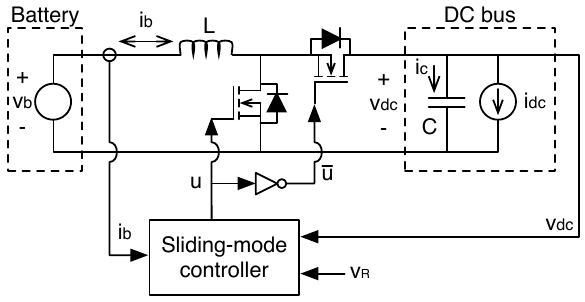
Figure 3. Structure of a unified sliding-mode controller for the